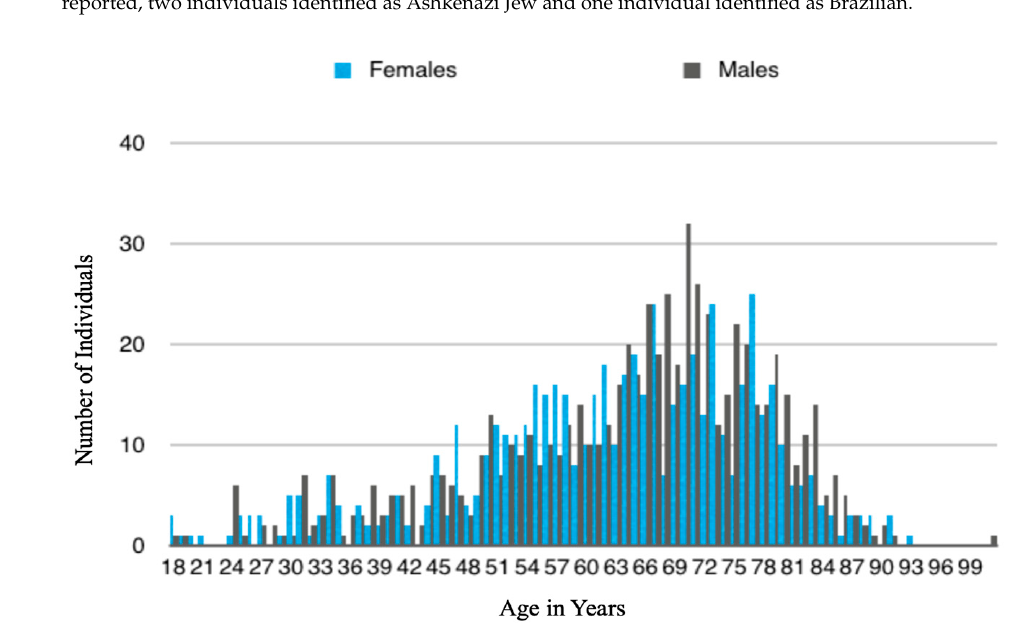
Figure 1. Descriptive statistics: Age distribution by sex ( n = 1238, 18 to 101 years). Table 2. T-test analyses comparing estimated mean age versus actual age by ordering department.